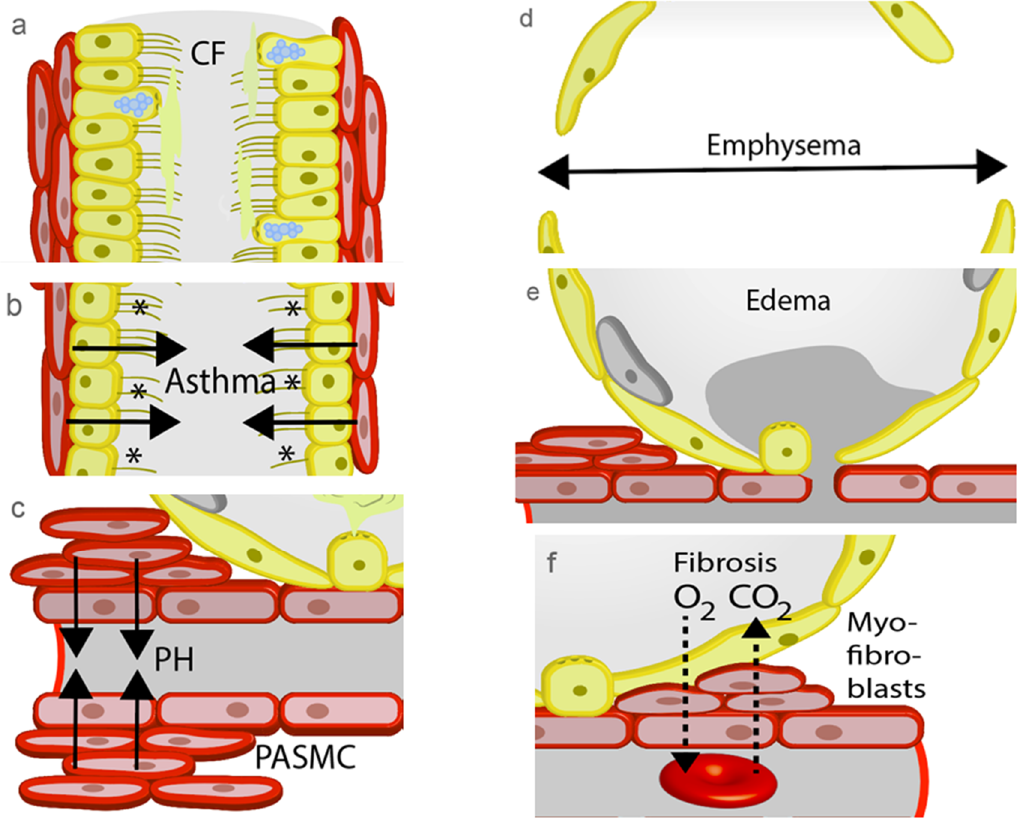
Figure 2. Pathophysiological changes in the lung. ( a ) Increasing viscosity of the mucus during the development of cystic fibrosis (CF) disables removal of foreign particles. ( b ) Contractions of the airways by allergens (*) occur during an asthma attack and prevents gas exchange. ( c ) Precapillary arterial smooth muscle cell (PASMC) contract to increase pulmonary blood pressure as an initial step in the development of pulmonary hypertension (PH). ( d ) A hallmark of chronic obstructive pulmonary disease (COPD) is the loss of alveolar septae during the development of emphysema. ( e ) Increased hydrostatic pressure by PH or damage of the alveolar capillary membrane induce lung edema. ( f ) Repair processes by myofibroblasts block gas exchange in the alveolar capillary membrane of patients with lung fibrosis.